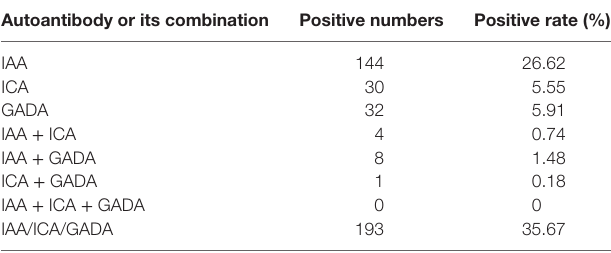
TaBle 1 | Detection of serum autoantibodies and their combinations in elderly type 2 diabetes. autoantibody or its combination